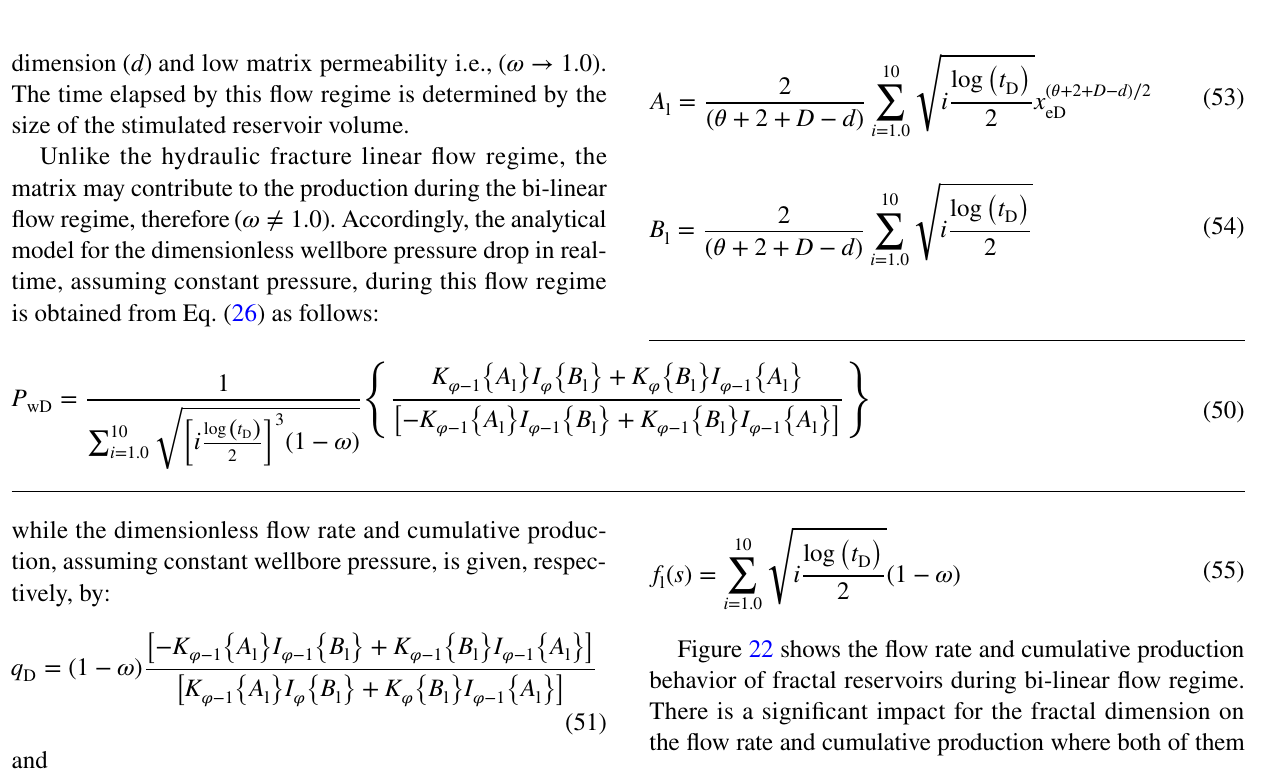
Fig. 21 Wellbore pressure and derivative of bi-linear flow